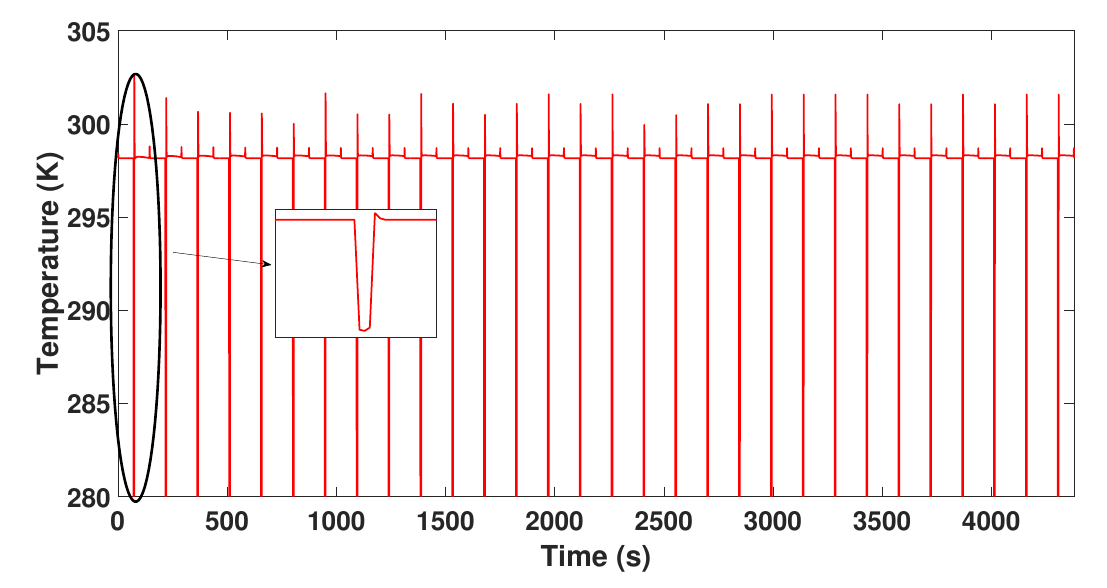
Figure 4. Temperature from start-up to CSS.